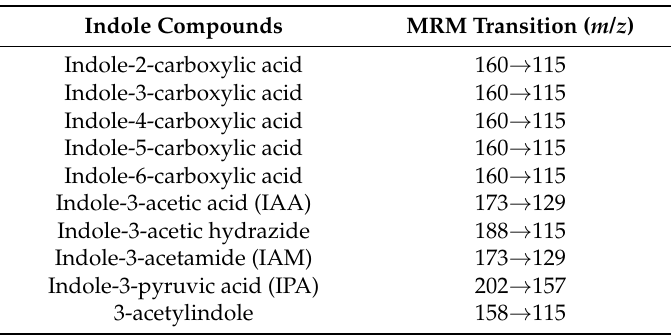
Table 1. MRM transition result of 10 indole